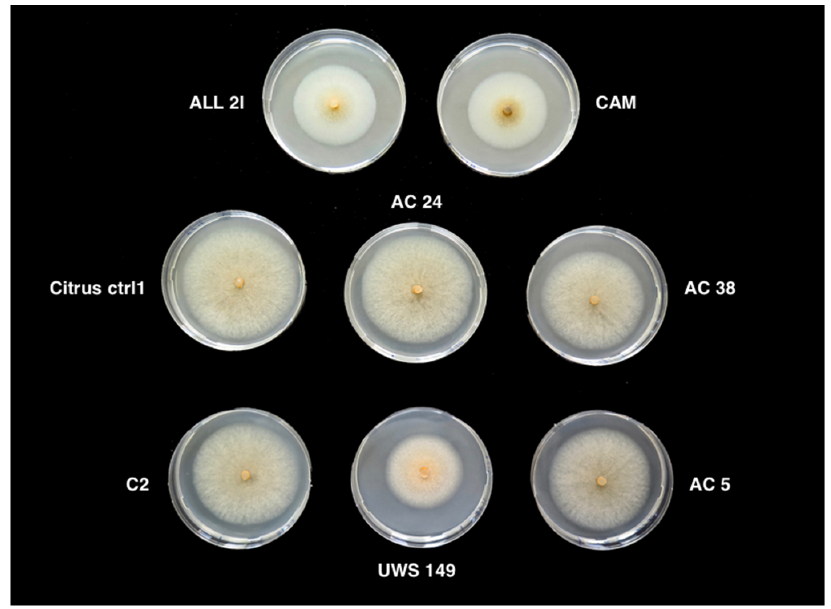
Figure 1. ( A ). Shoot blight and dieback of entire branches on Sweet orange “Tarocco Scirè” injured by wind. ( B ) Symptoms of shoot blight incited by Colletotrichum infections on Sweet orange “Tarocco Scirè” injured by wind. ( C ) Gumming associated with citrus shoot blight on Sweet orange “Tarocco Scirè”. ( D ) Leaf mesophyll collapse and necrosis caused by wind on leaves of “Tarocco Scirè” sweet orange. Conidiomata of Colletotrichum are visible on necrotic lesions as black pin point-dots.